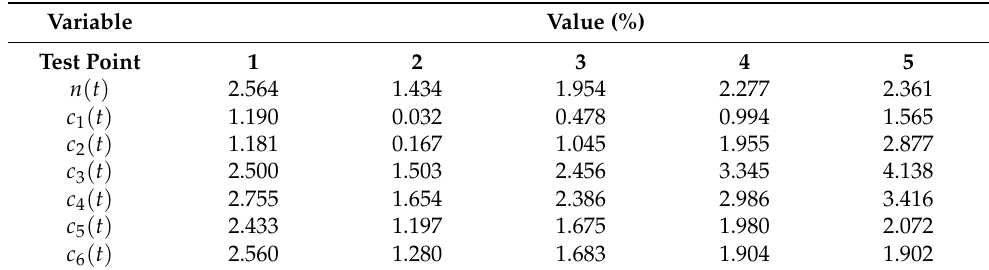
Table 5. Case 2. Percentage error of extrapolation of the training data in time interval t ∈ [ 0, 207 ] s using five testing points in time interval t ∈ [ 208, 217 ] s